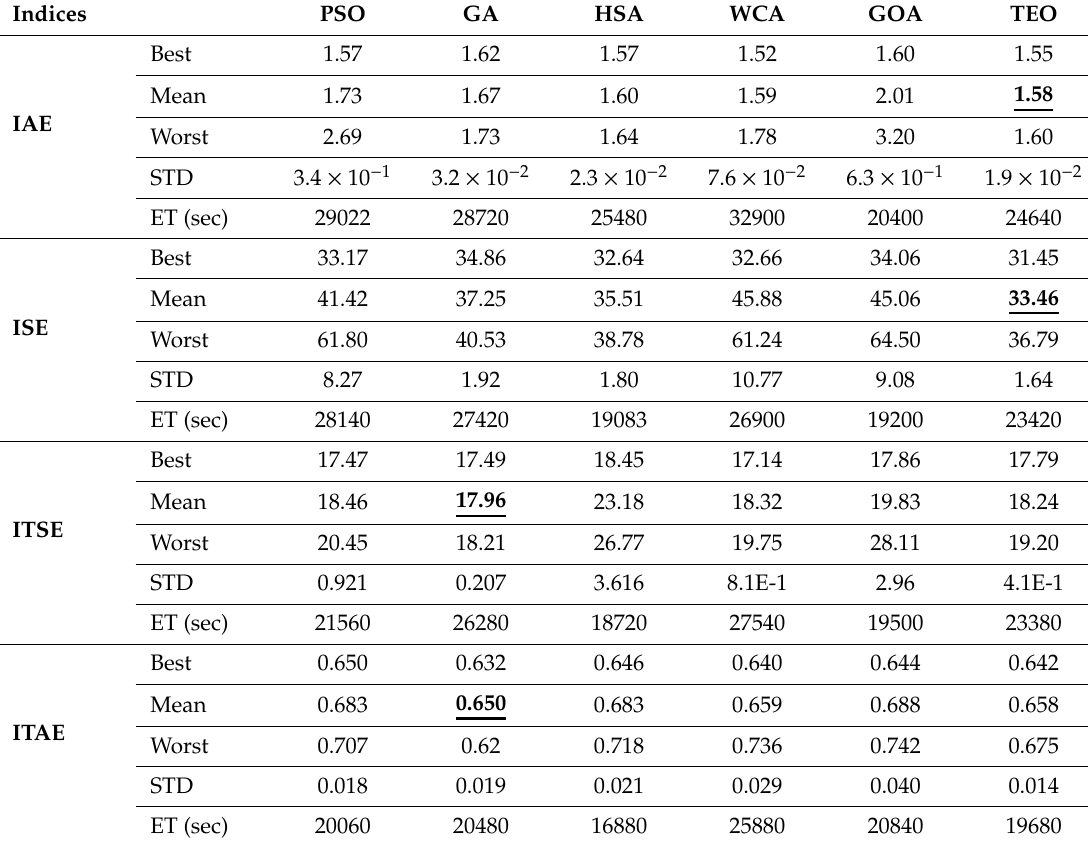
Table 3. Statistical results of optimization problem (19) over 10 independent